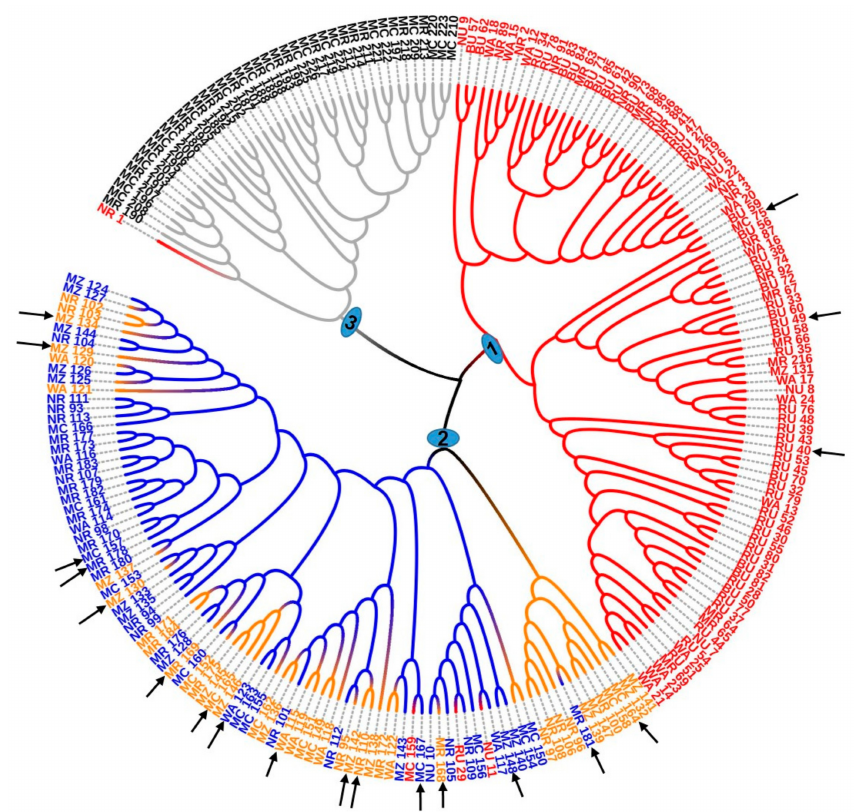
Figure 7. A simple sequence repeat (SSR) based dendrogram of the genetic relationship between the 226 avocado samples showing three major groups; group 1 and 3 correspond to clusters 1 and 3, respectively, and group 2 was a mosaic of individuals of two closely related clusters, i.e., cluster 2 (in orange) and cluster 4 (in blue) with three individuals from cluster 1 (in red). Samples marked with the same color belong to the same cluster. Highly admixed samples are indicated with